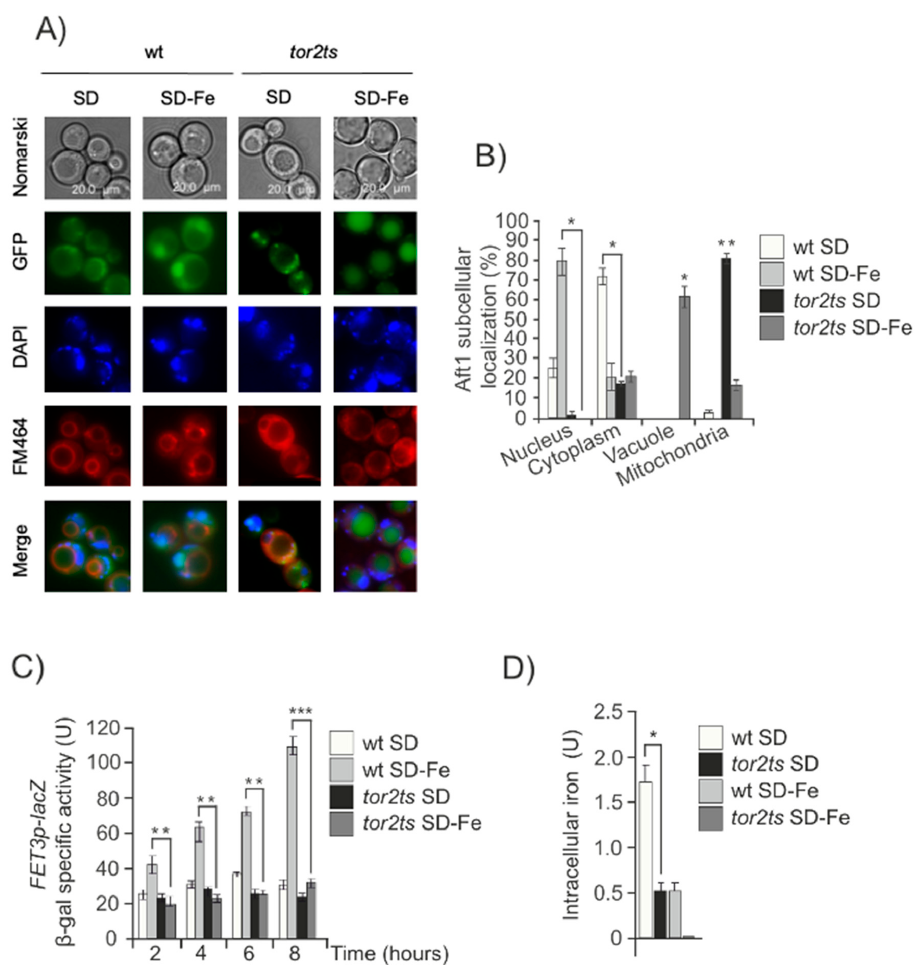
Figure 1. TORC2 regulates iron starvation signal. ( A ) wt and tor2ts cultures transformed with pAft1GFP. A preculture of exponentially growing cells at 25 ◦ C was set. Cells from this preculture were transferred to 38 ◦ C to OD 600 : 0.3 for 2 hours. Aliquots were collected for in vivo observation in the fluorescence microscope. ( B ) Histogram of Aft1 localization quantified in the experiment described in ( A ) was calculated upon microscopic observation of 1000 cells. The results shown are normalized and only the alive cells are taken into account. ( C ) ß-galactosidase activity content determination in wt and tor2ts strains. Cells were grown at 30 ◦ C in SD media to OD 600 :0.4. Aliquots were taken, washed and transferred to SD or SD-Fe media at 38 ◦ C for 8 hours. Samples were taken every two hours to determine the ß-galactosidase activity reporter construct. ( D ) Intracellular iron content was determined in wt and tor2ts exponential cultures grown in SD or SD-Fe media at 38 ◦ C as described under Material and Methods. For all the figures: Error bars in the histograms represent the standard deviation (SD) calculated from three independent experiments. Significance of the data was determined by p -values from a Student unpaired t -test denoted as follows: * 0.05 > p > 0.01; ** 0.01 > p > 0.001; *** 0.001 > p >